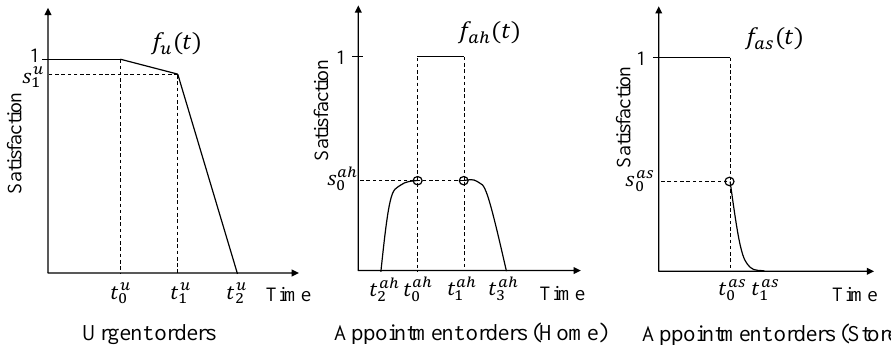
Figure 2. Measurement of satisfaction for online